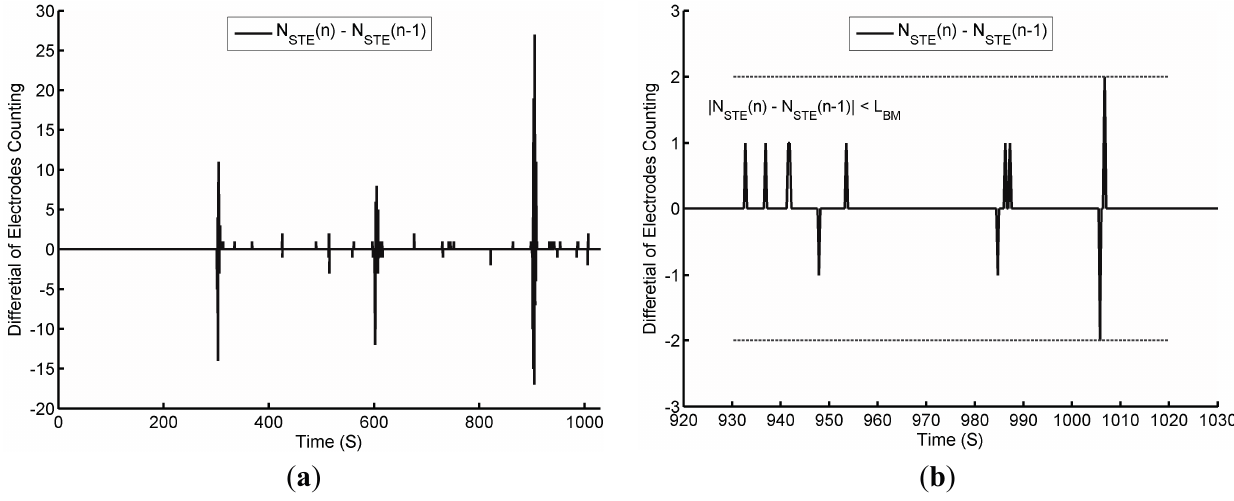
Figure 9. The differential value of N STE : ( a ) Throughout the experiment; ( b ) Enlargement of differential value showing the breathing